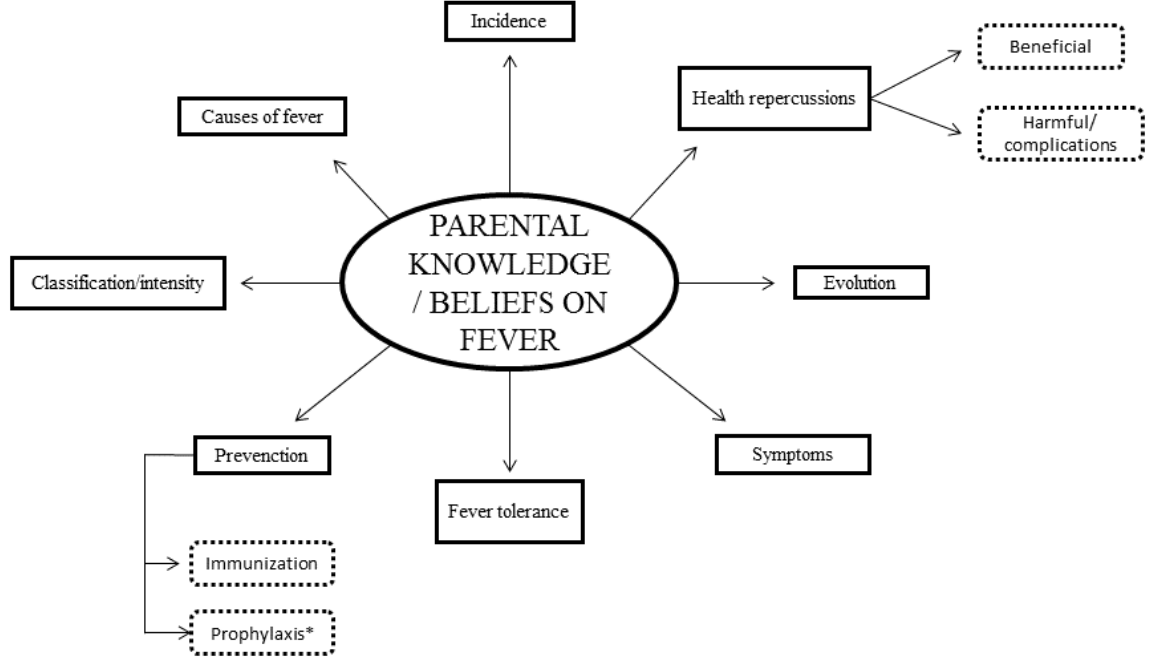
Figure 1. Knowledge and beliefs of parents on Figure 1. K nowledge and beliefs of parents on fever.